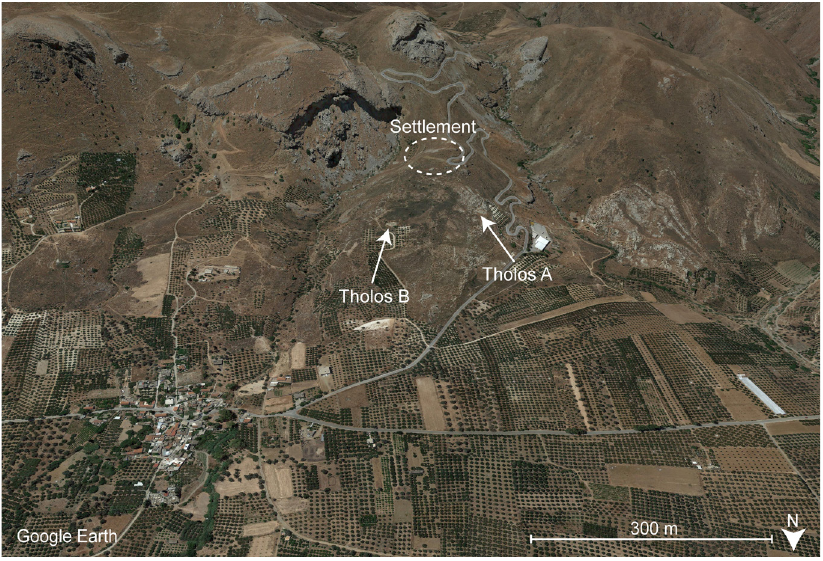
Figure 2. Tholos A, Tholos B and the settlement at Apesokari in their topographic context (Google Earth image; elevation exaggeration: